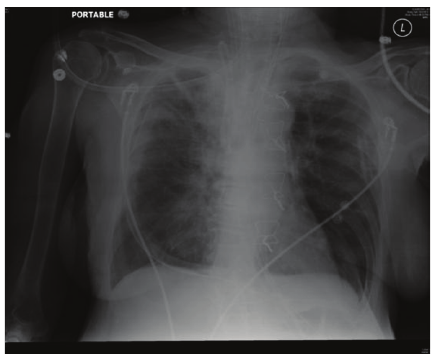
Figure 4: Postoperative chest X-ray: significant improvement of the right mediastinal